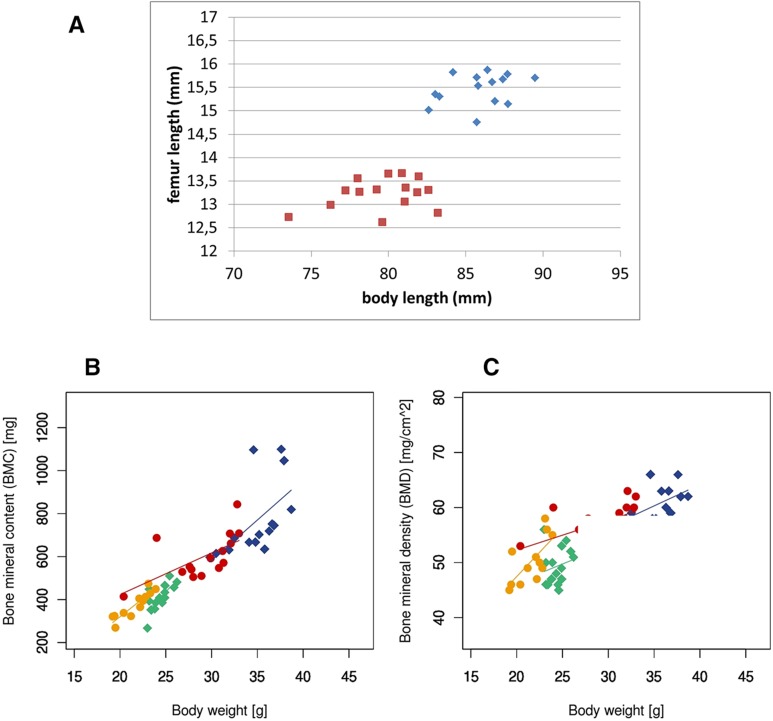
Skeletal abnormalities in Scube3N294K/N294K mice. (A) Femur length of female animals plotted by body length (red, Scube3N294K/N294K and blue, Scube3WT. (B) Bone mineral content plotted by body weight (green, Scube3N294K/N294K males; yellow, Scube3N294K/N294K females; blue, Scube3WT males; and red, Scube3WT females). (C) Bone mineral content plotted by body weight (green, Scube3N294K/N294K males; yellow, Scube3N294K/N294K females; blue, Scube3WT males; red, Scube3WT females).